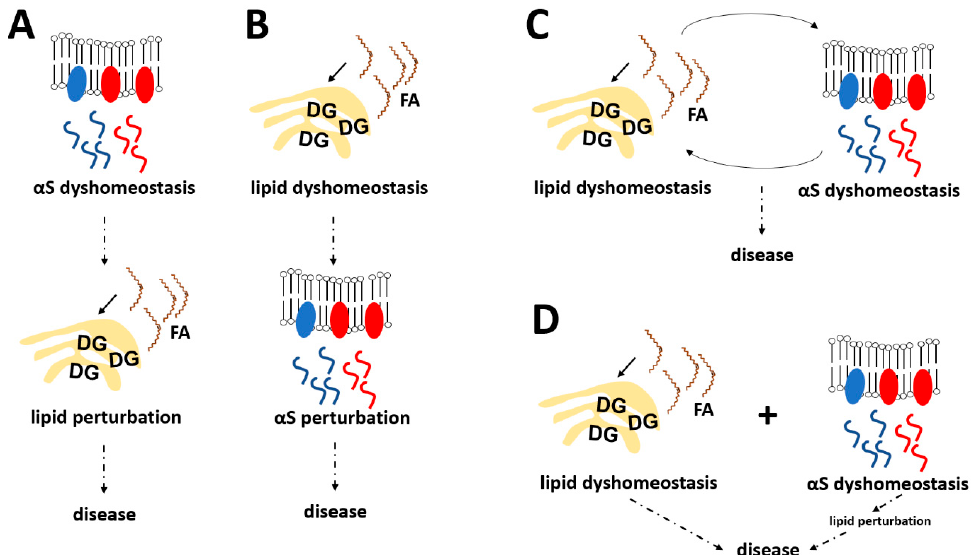
Figure 3. The interplay between α S and lipid biology in synucleinopathies—possible scenarios. ( A ) α S imbalance is upstream of abnormal lipid alterations. ( B ) Lipid imbalance is upstream of abnormal α S alterations. ( C ) α S imbalance and lipid imbalance influence and reinforce each other. ( D ) Primary lipid imbalance and α S-induced lipid imbalance are additive. α S, α -synuclein; FA, fatty acid; DG, diacylglycerol.